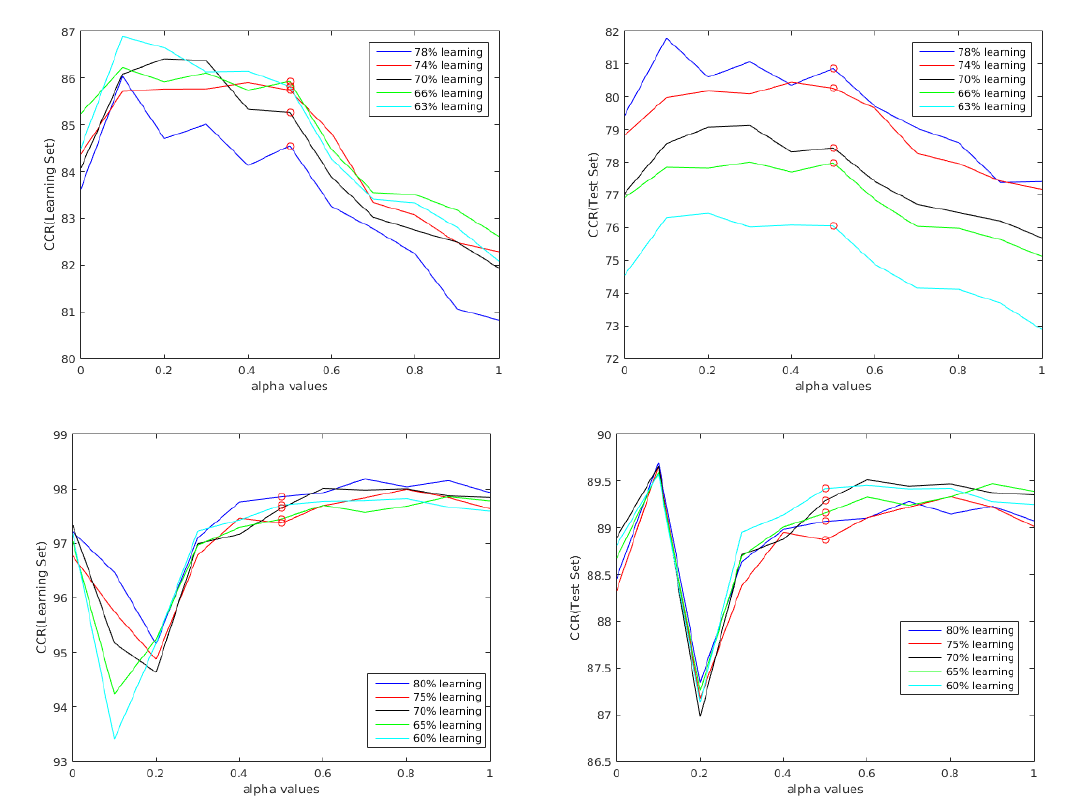
Figure 2: Correct Classification Rate (CCR) obtained with Sylla & Girard kernel (5, 6) for α ∈ { 0, 0.1, . . . , 1 } and several propor- tions τ . The results obtained with the RBF kernel ( α = 0.5 ) are emphasized by a red circle. Left: CCR computed on the learning set, Right: CCR computed on the test set. Top: results obtained on the verbal autopsy data, bottom: results obtained on the handwritten digit